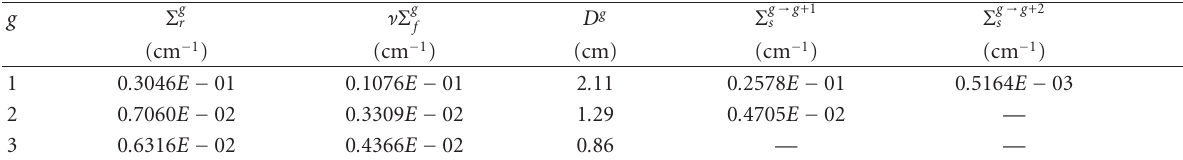
Table 1: Material data for the homogeneous core.